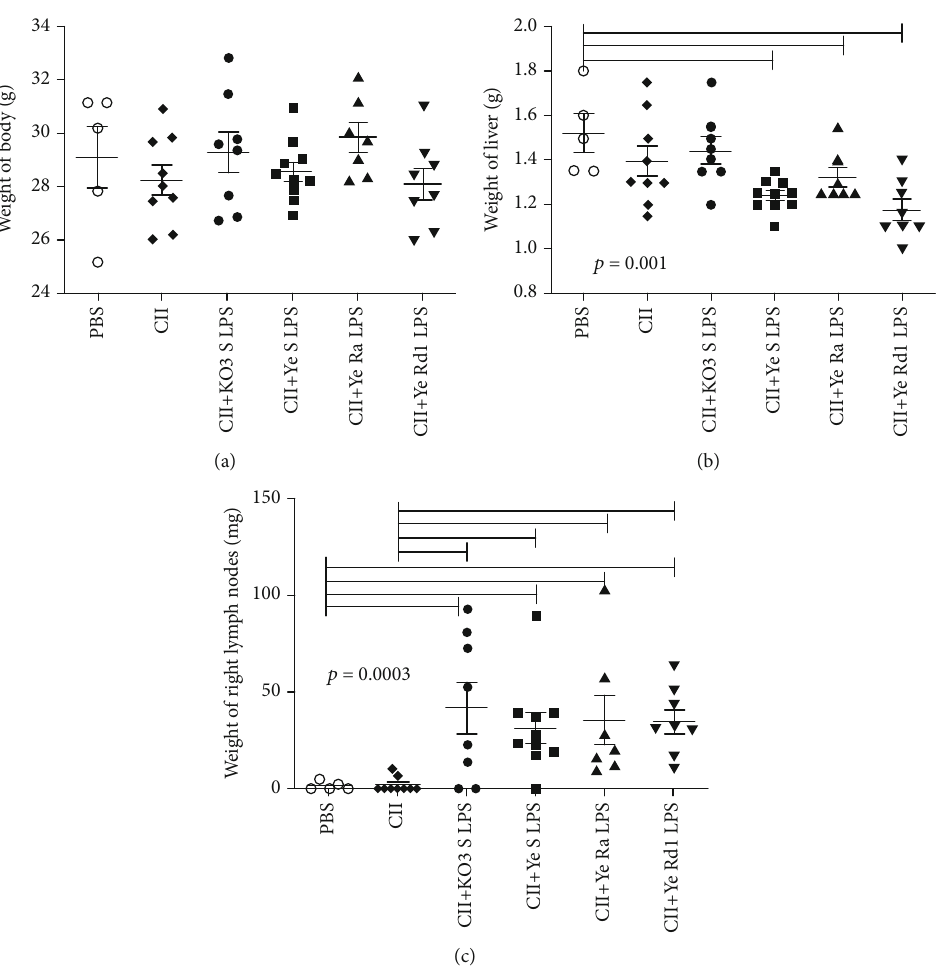
Figure 7: The consequences of long-term treatment of mice with collagen type II and its mixture with LPS. Body weight (a), weights of the liver (b), and inguinal right lymph nodes (c) were analyzed using ANOVA Kruskal-Wallis with Dunn ’ s post hoc test. The individual values, mean, and SEM are presented. Horizontal lines show the statistically signi fi cant di ff erences between analyzed